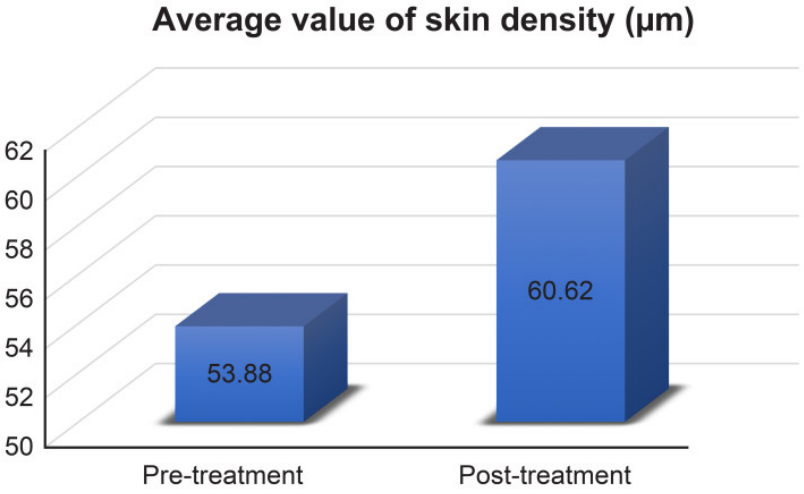
Figure 5. Average values of skin density measurement results. Pre-treatment 53.88 ± 2.72μm, post-treatment 60.62 ± 4.201μm.